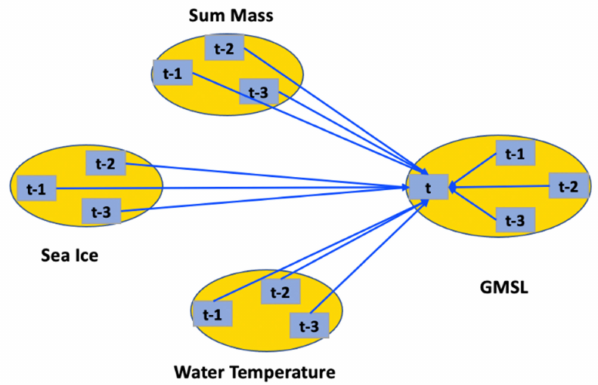
Figure 4. Path diagram for VAR(3) with GMSL being the response variable and three predictors selected from the dynamic SEM